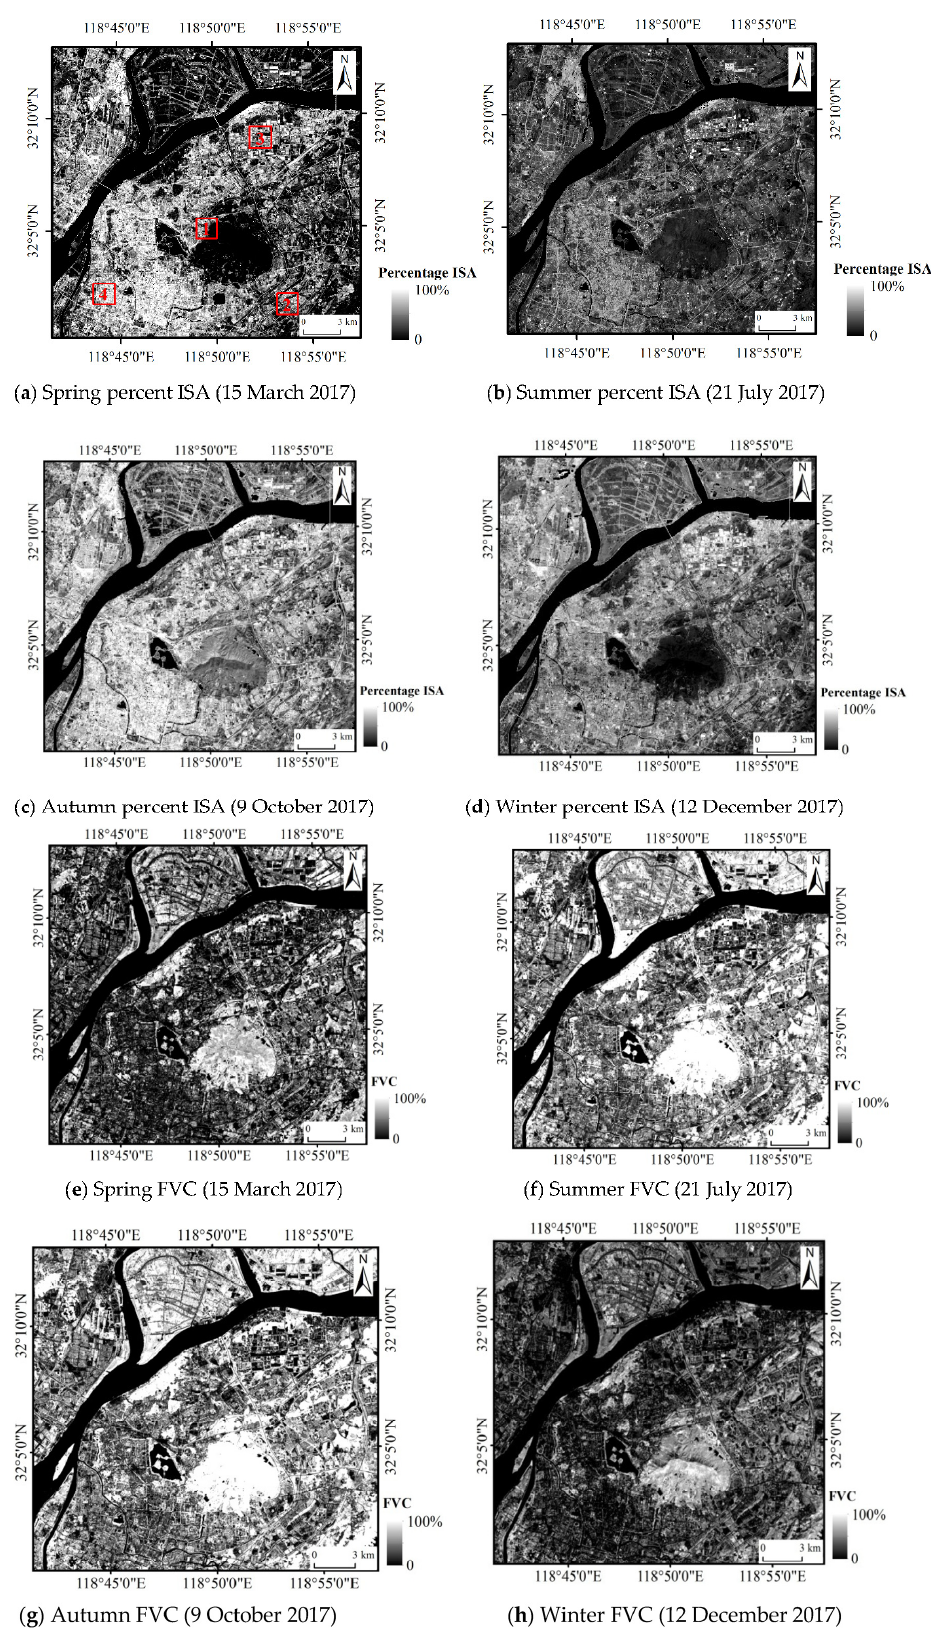
Figure 3. Fractional cover images of impervious surface areas and vegetation derived by FCLS in the four seasons of 2017. The four sample plots in ( a ) were selected for accuracy assessment. In order to assess the accuracy of the fractional cover images of ISA and vegetation derived by FCLS, we compared the fraction estimates in the sample areas with the ref- erence data derived from the high-resolution GF-1 image. The maximum likelihood classification algorithm was used to classify the ISA and vegetation classes in the GF-1 data, and the sample areas were selected as reference data. The four sample areas in Figure 3a representing the whole study area were selected to analyze the accuracy. In this study, we only assessed the accuracy of the fractional covers derived from the Landsat data acquired in spring because the acquisition date of the high-resolution image (ac- quired on 2 March 2017) was close to the acquisition date of the Landsat 8 data (acquired on 15 March 2017). This approach was applicable because their acquisition dates are very close, so the land cover/vegetation phenology hardly changed between the acquisition dates of the high-resolution data and the spring Landsat 8 data. The overall classification accuracy in the four sample plots was very similar, with less than 7% difference between the fractional covers of ISA and vegetation derived from Landsat and high-resolution data (Table 1). This accuracy can also represent the accuracy of fractional covers derived for the other three seasons. Considering the heterogeneity of the urban landscape pattern, the results indicated good agreement for ISA and vegetation cover between the areas obtained from Landsat and high-resolution data. Therefore, our method to derive fractional cover is reliable. We do not provide accuracy assessments for the other three seasons here because high-resolution images for those seasons were not available. Table 1. Accuracy assessment of the fractional cover of ISA and vegetation (derived by FCLS from a Landsat 8 image acquired on 15 March 2017. Areas measured in km 2 . Area from the OLI Image Area from the GF-1 Image